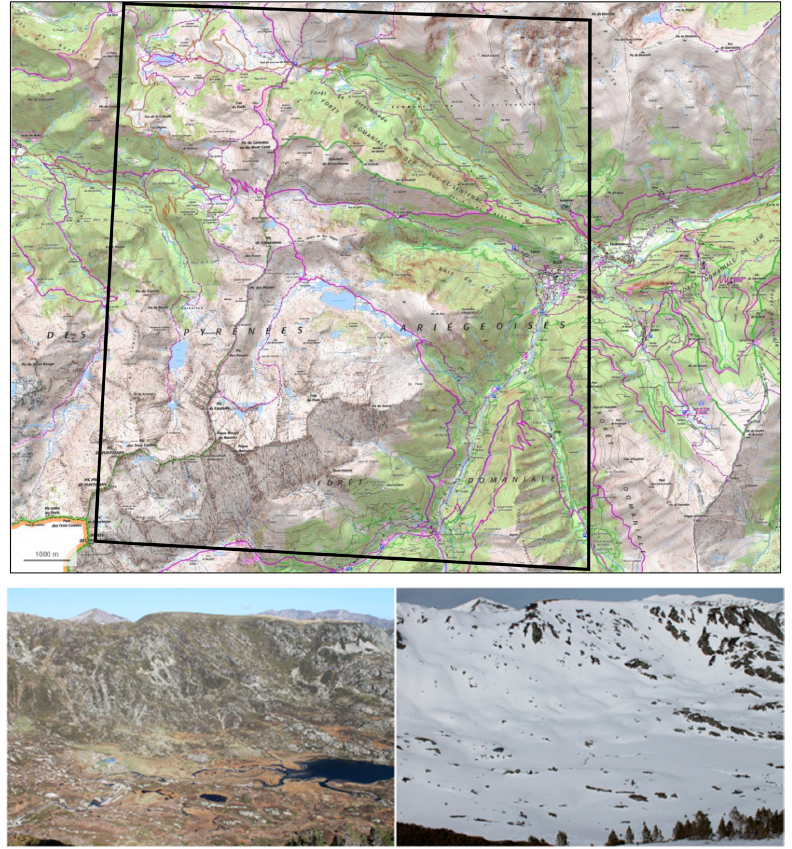
Figure 2. Top: topographic map of the Bassies area (42°45 ′ N, 1°25 ′ E in the Pyrenees, France). The black polygon indicates the outline of the Pléiades acquisition (source: IGN/SCAN25, www.geoportail.gouv.fr). Bottom: photographs taken from Col de la Serrette near the geographic center of the study area (26 October 2014, 11 March 2015).